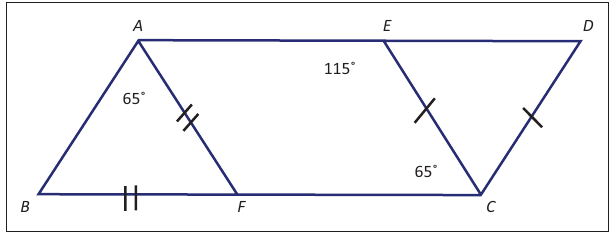
FIGURE 4: Proving a quadrilateral to be a